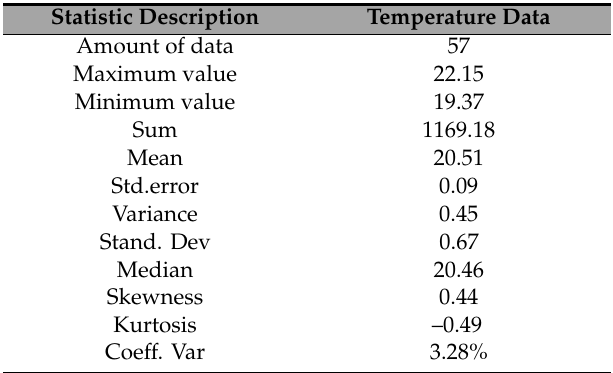
Table 1. Annual average maximum temperature summary